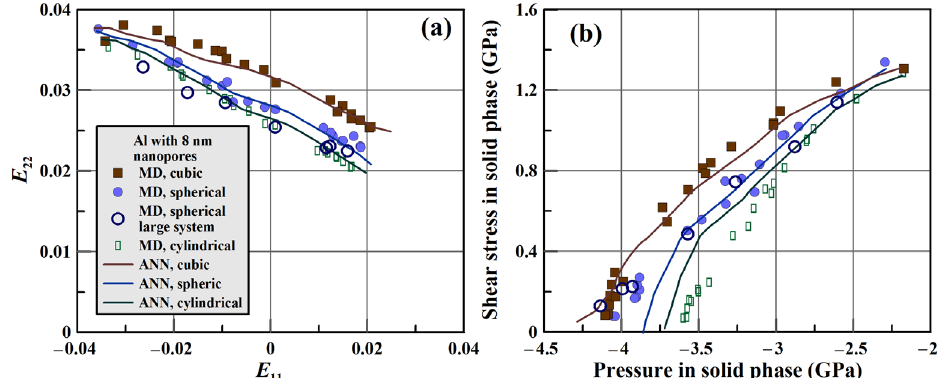
Figure 8. Threshold of dislocation nucleation at tension of pore-free aluminum and nanoporous aluminum with 8 nm spherical pores at different temperatures (300 K and 700 K). Symbols showing MD data and lines showing the ANN-based prediction for the nucleation threshold are plotted ( a ) and ( b ) as the dependencies of the critical shear stress in the in the deformation space solid phase on the pressure in the solid phase. { 𝐸𝐸 11 , 𝐸𝐸 22 }